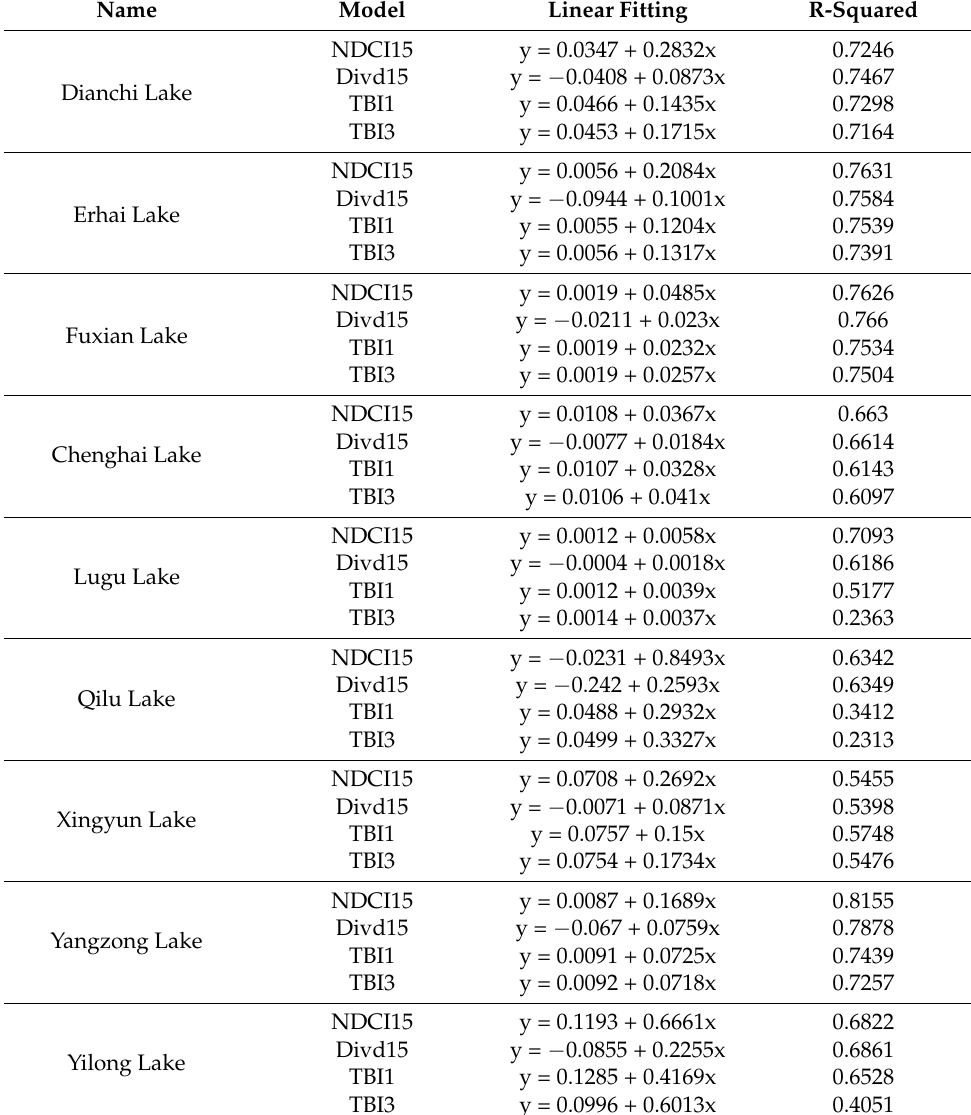
Table 5. Linear fitting